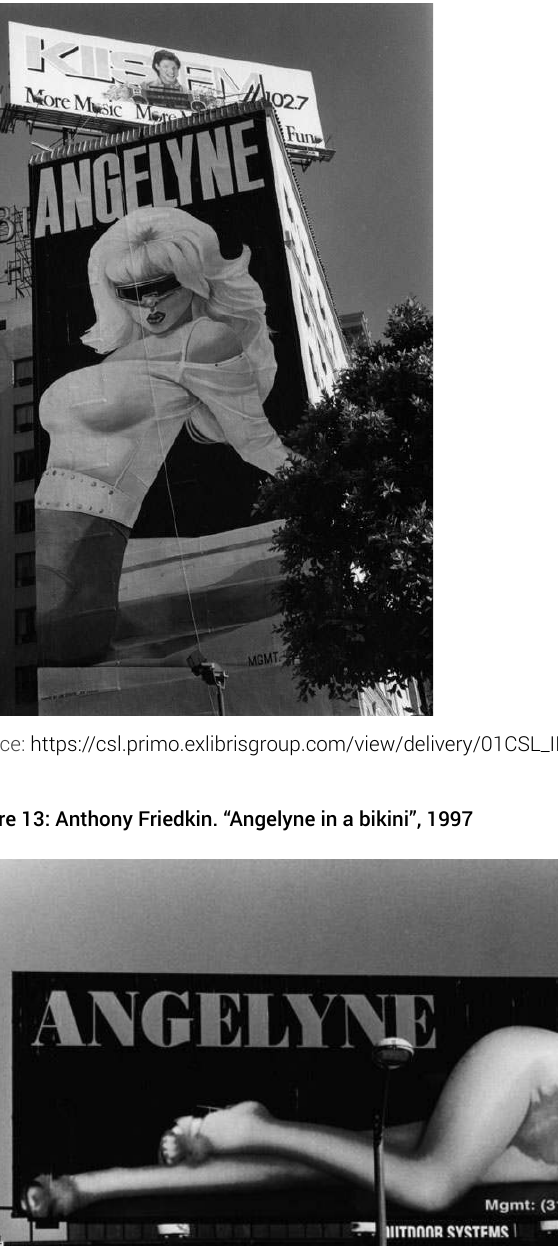
Figure 12: William Reagh. [Painted billboard of Angelyne on building], 1986